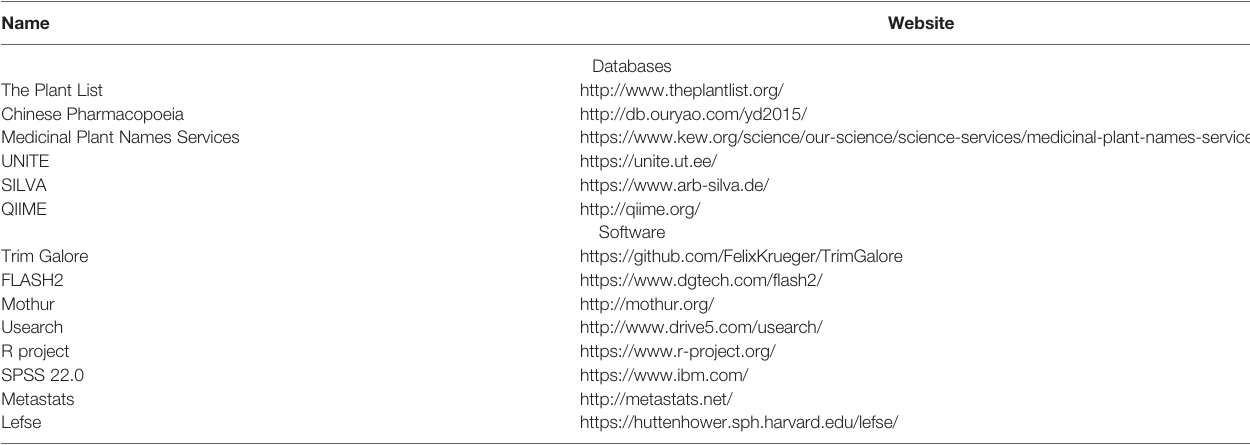
TABLE 2 | The used databases and software in the